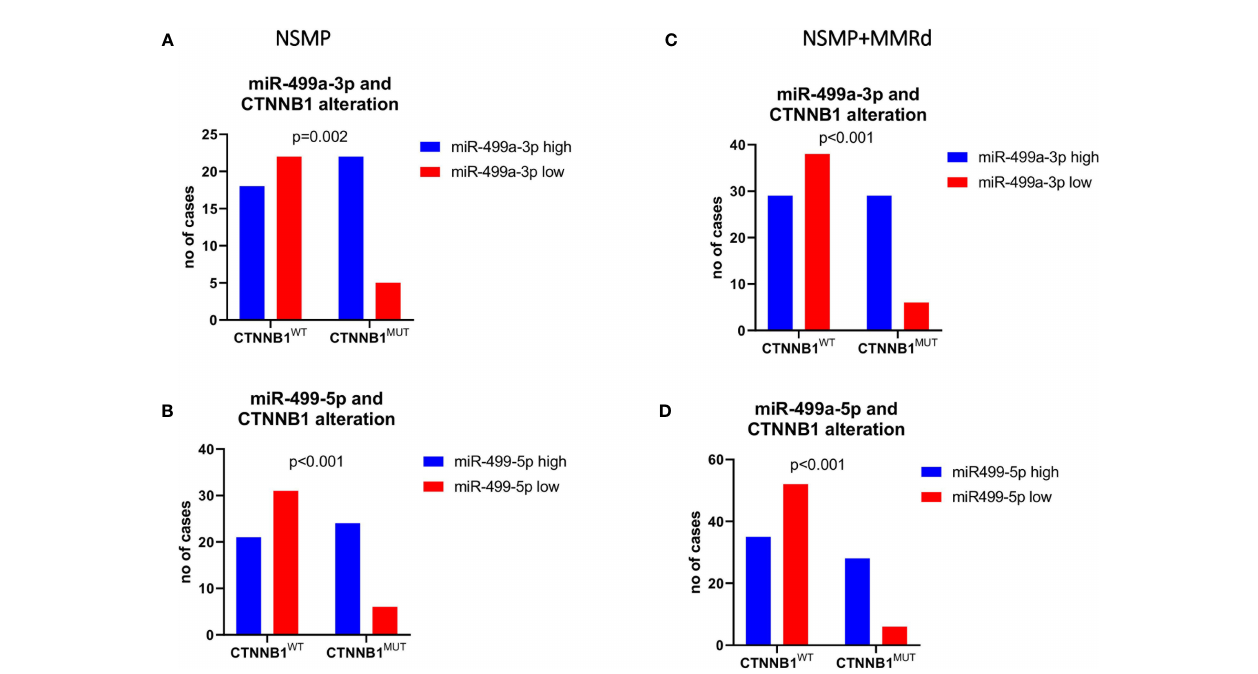
FIGURE 3 | Chi-square test was used to test the distribution of low/high miR-499a-3p (A, C) and 5p (B, D) expression across the CTNNB1-mutated versus wild- type patients ’